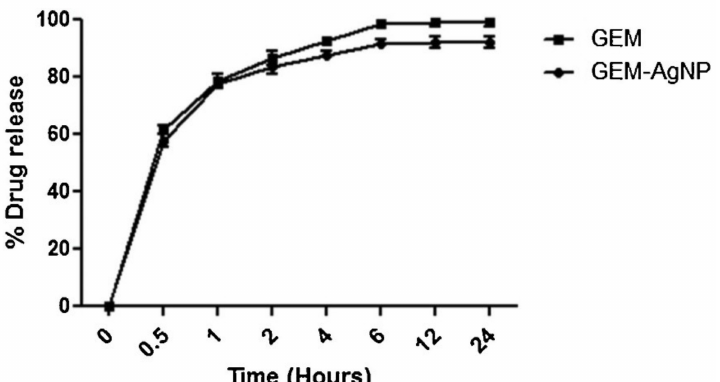
Figure 11. Profiles of GEM release, free in solution and from GEM-AgNPs, in a phosphate buffer solution (pH = 7.4), for 24 h. Reprinted from [59], with permission from Elsevier,